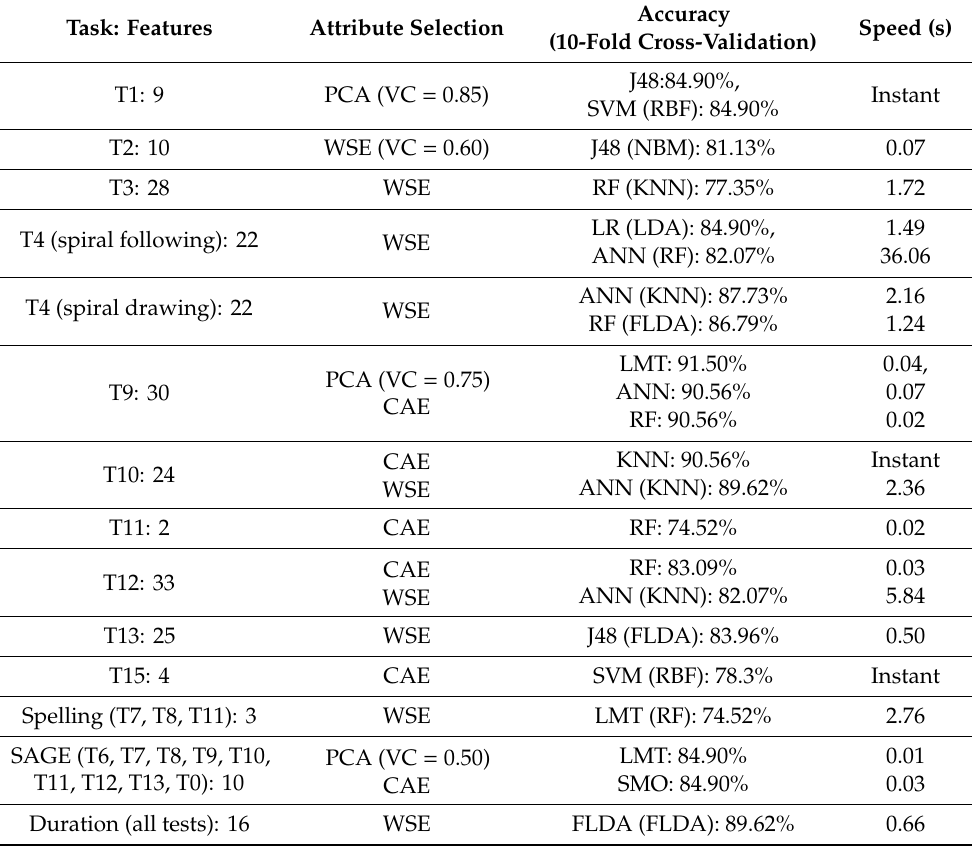
Table 2. Healthy vs. impaired classification results of individual